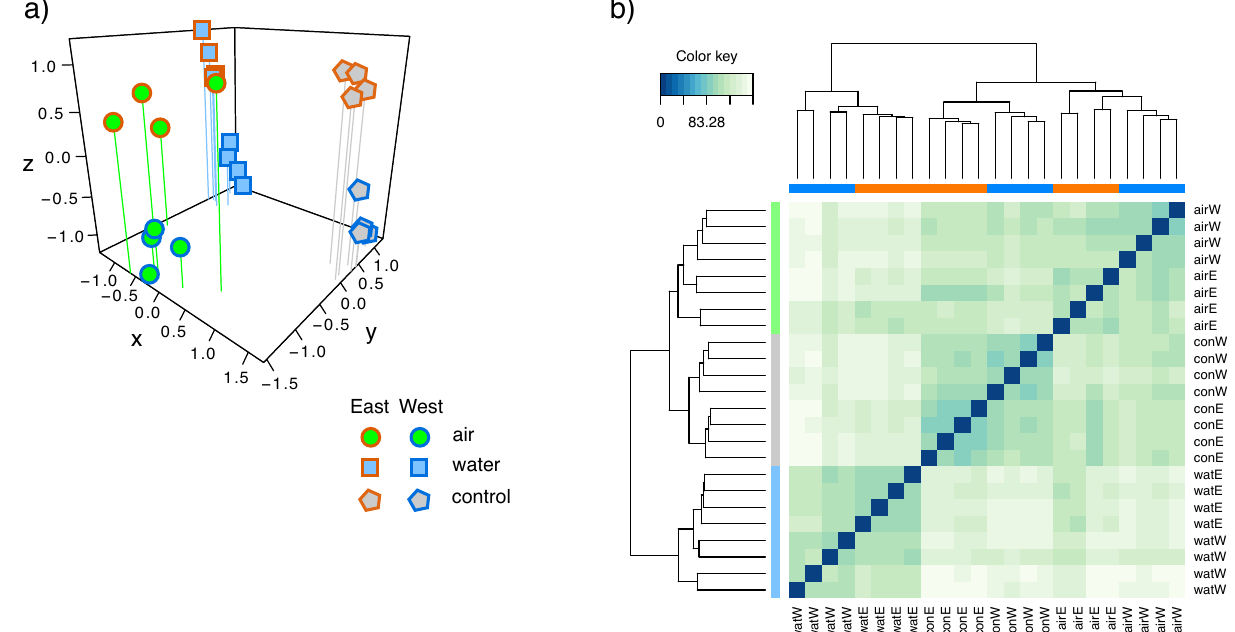
Figure 4. Sample clustering. Multidimensional scaling of samples (15,725 transcripts passing edgeR expression filters) in 3 dimensions coloured by treatment ( a ) and lineage ( b ). Sample distances for the same data ( c ) with row annotations indicating treatment (green = “AIR”, grey = “CONTROL” and light blue = “WATER”) and column annotations indicating lineage (blue = “West” and orange =